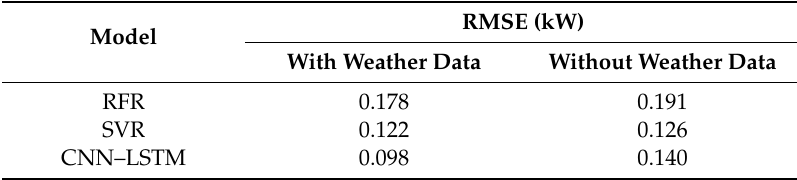
Table 14. Comparison between CNN–LSTM and other